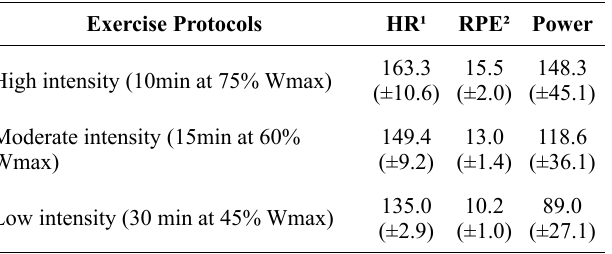
Table 2. Mean (± standard deviations) of heart rate (HR) 1, Borg rat - ing of perceived exertion (RPE) 2 and power (watts) during exercise protocols on a cycle ergometer.